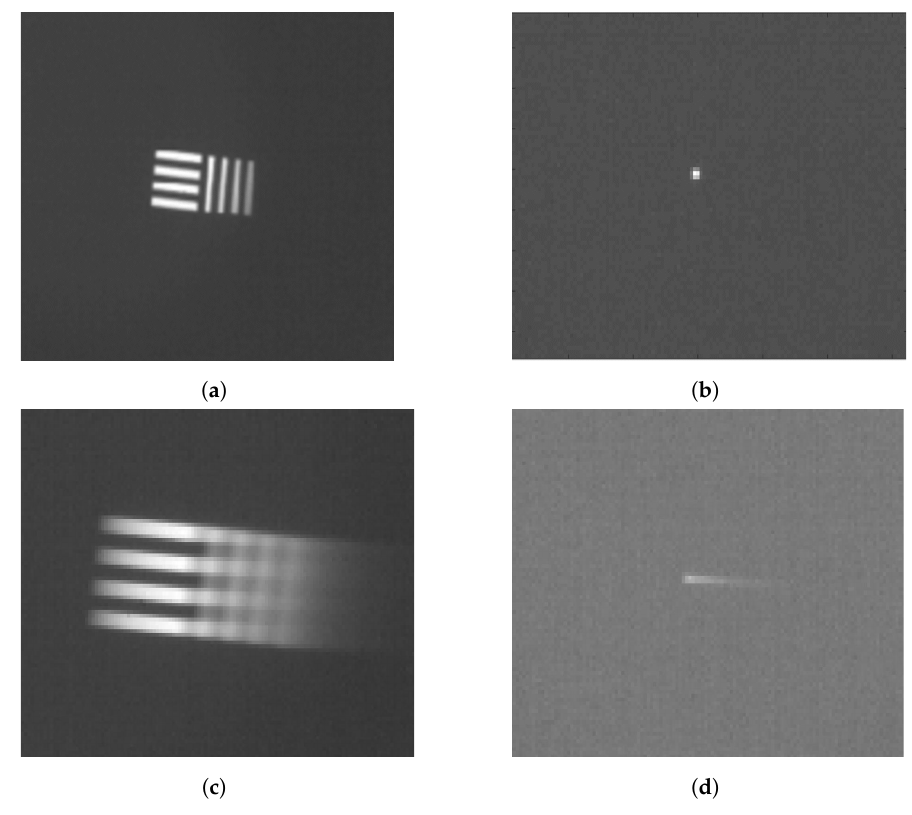
Figure 4. Examples of motionless and moving pattern images. ( a ) 4-bar pattern, ( b ) Point source, ( c ) 4-bar pattern at 40 ◦ /s, ( d ) Point source at 40 ◦